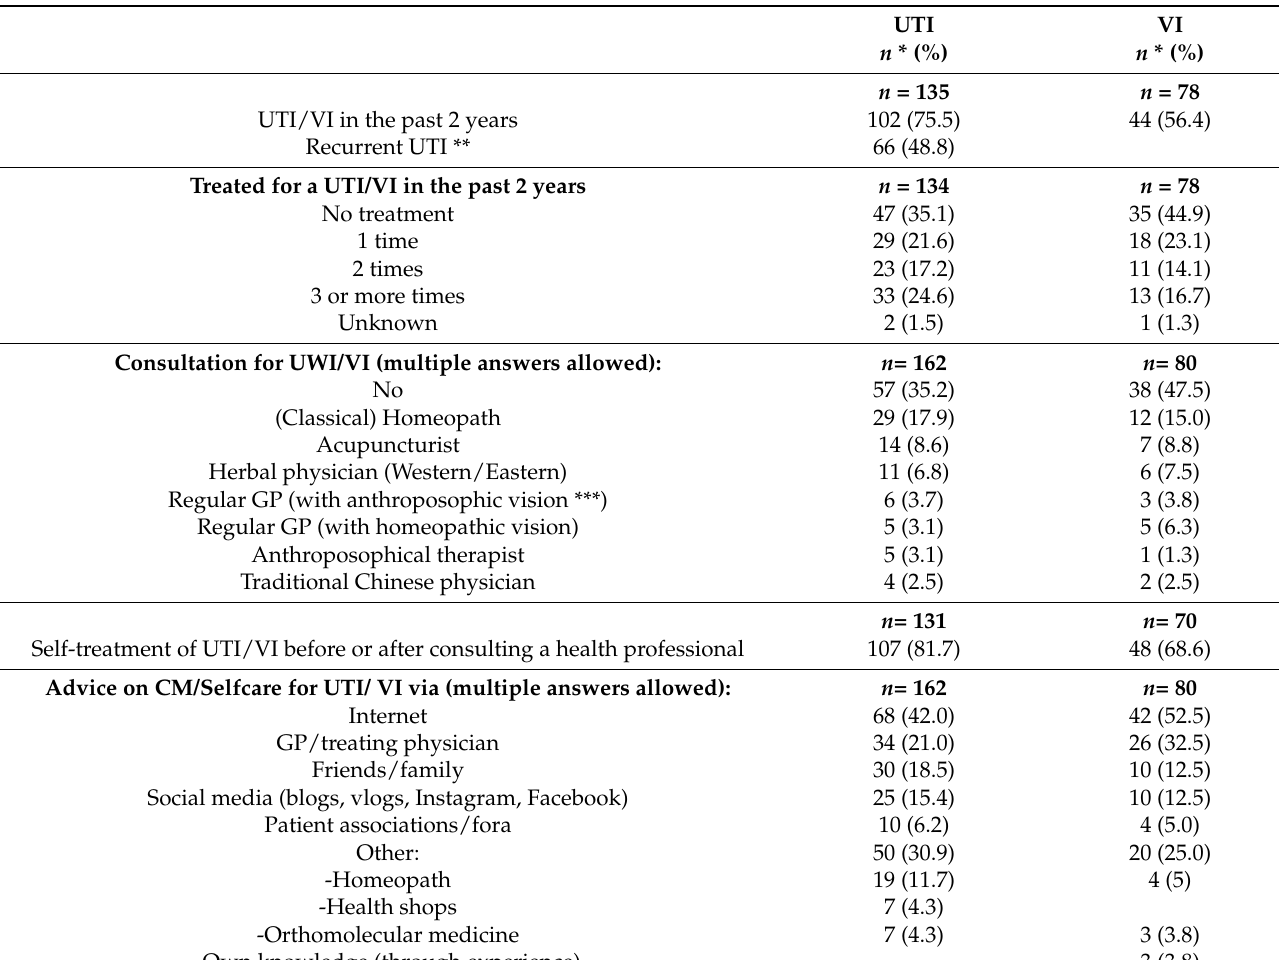
Table 2. Incidence, consultation, and treatment of urinary tract infection (UTI) and vaginal infection (VI) in women with a history of UTI ( n = 162) and women with a history of UTI and VI ( n =